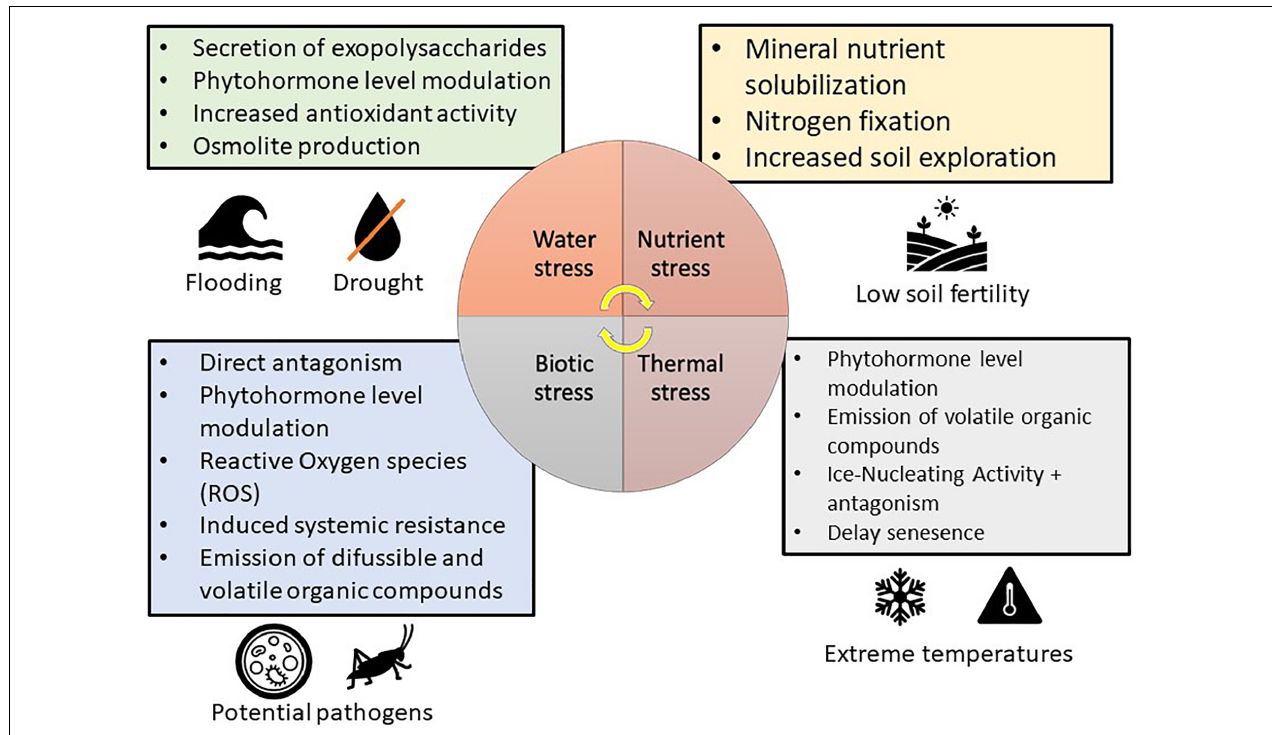
FIGURE 2 | Protective mechanisms used by microbial biostimulants in mitigation of various stresses in plants (modified from Sangiorgio et al., 2020).